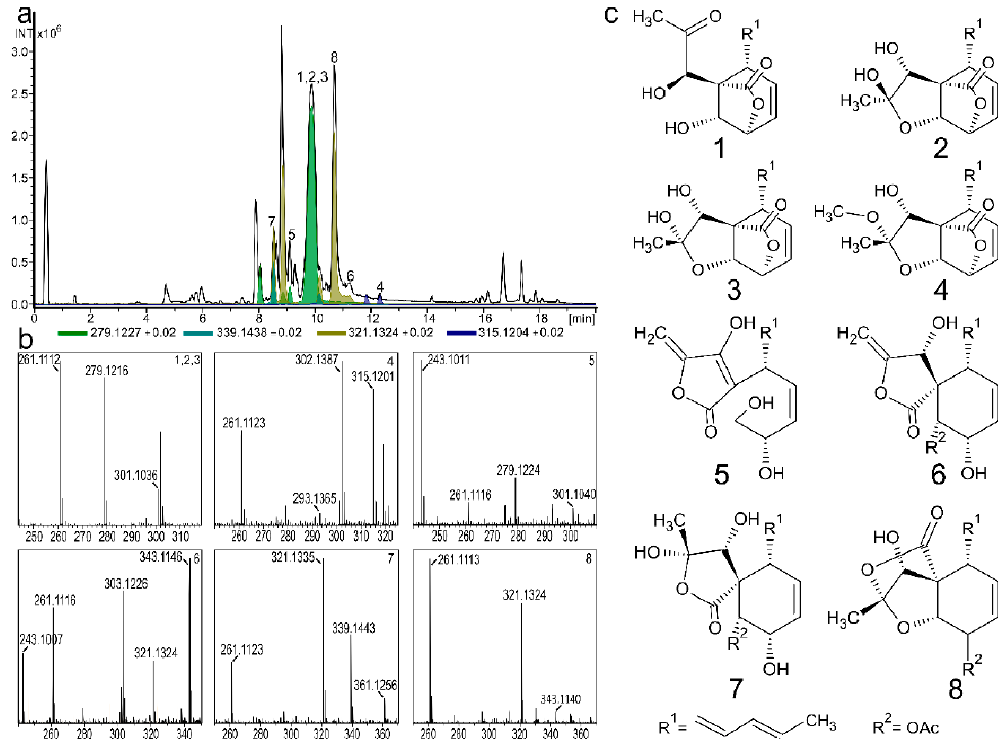
Figure 2. HPLC-HRMS of a pre-fractionated metabolite extract from F. avenaceum grown on banana media showing 1 – 8 . ( a ) Base peak chromatogram (black) and colored extracted ion chromatograms of 1 – 8 . 1 – 3 and 5 [M + H] + EIC = 279.1227 Da. 4 [M + Na] + EIC = 315.1204 Da. 6 and 8 [M + H] + EIC = 321.1324 Da. ( 7 ) [M + H] + EIC = 339.1438 Da.; ( b ) six mass spectra showing ion adducts